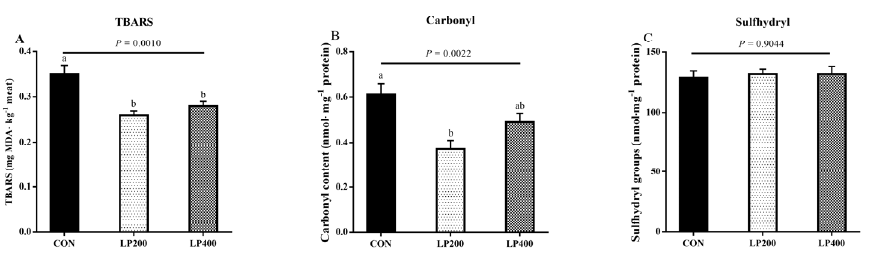
Figure 3. Thiobarbituric acid reactive substance (TBARS) ( A ), carbonyl ( B ) and sulfhydryl groups ( C ) content of muscle in response to lycopene added to the diet on day 0 ( n = 10). Different lowercase letters indicate significant differences ( P < 0.05) among treatments. The error bars represent standard error. NS, not significant. CON, control group; LP200 and LP400 mean 200 or 400 mg ∙ kg − 1 lycopene powder supplementation in the control diet, respectively.